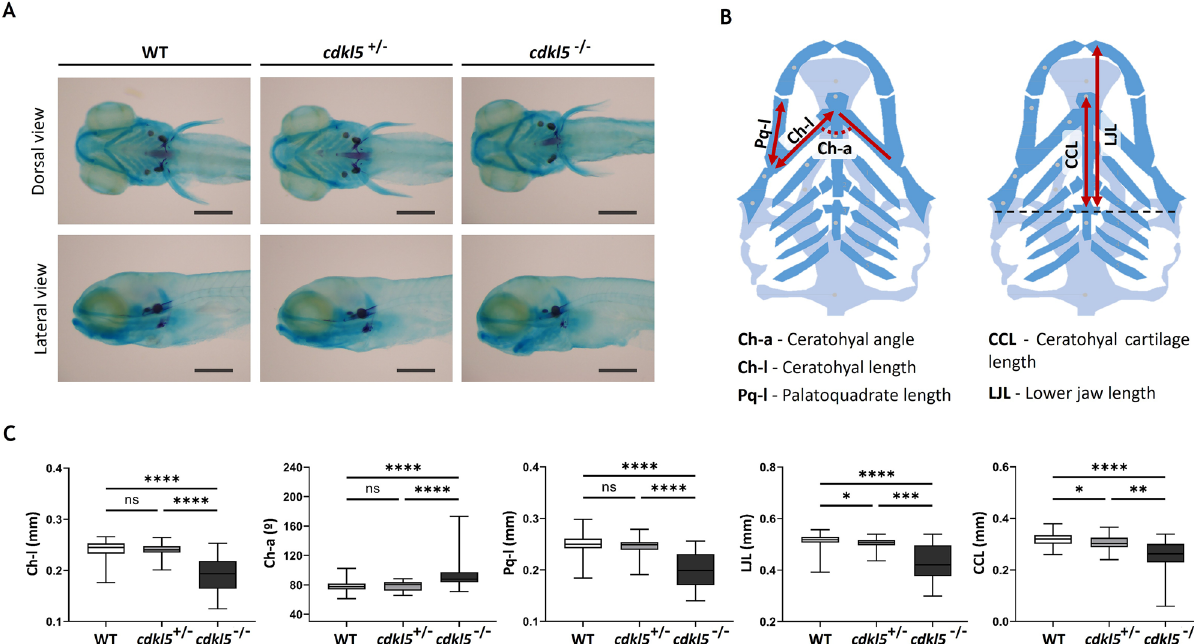
Figure 4. Craniofacial development of cdkl5 sa21938 mutants with 5 dpf. ( A ) Representative images of the wild- type (WT), heterozygous ( cdkl5 +/− ), and homozygous ( cdkl5 −/− ) embryos double-stained with alcian blue and alizarin red. Scale bar = 0.3 mm. ( B ) Illustration of the analyzed craniofacial cartilage parameters. Adapted from Raterman et al. 36 ( C ) Measurements of craniofacial cartilage parameters of WT (n = 59), cdkl5 +/− (n = 53) and cdkl5 −/− (n = 30) embryos. Three independent experiments were performed. Values are represented as median with interquartile range. Statistical analysis was performed using Kruskal–Wallis followed by Dunn multiple comparisons test. *, **, *** and **** indicate p < 0.05, p < 0.01, p < 0.001 and p < 0.0001, respectively. ns indicates not significant.